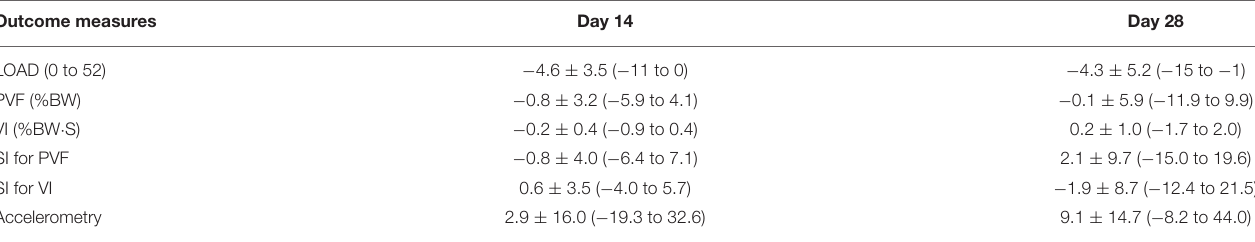
TABLE 3b | Changes from baseline in outcome measures at each time point in Part A of the study study (mean ± SD and range). Outcome